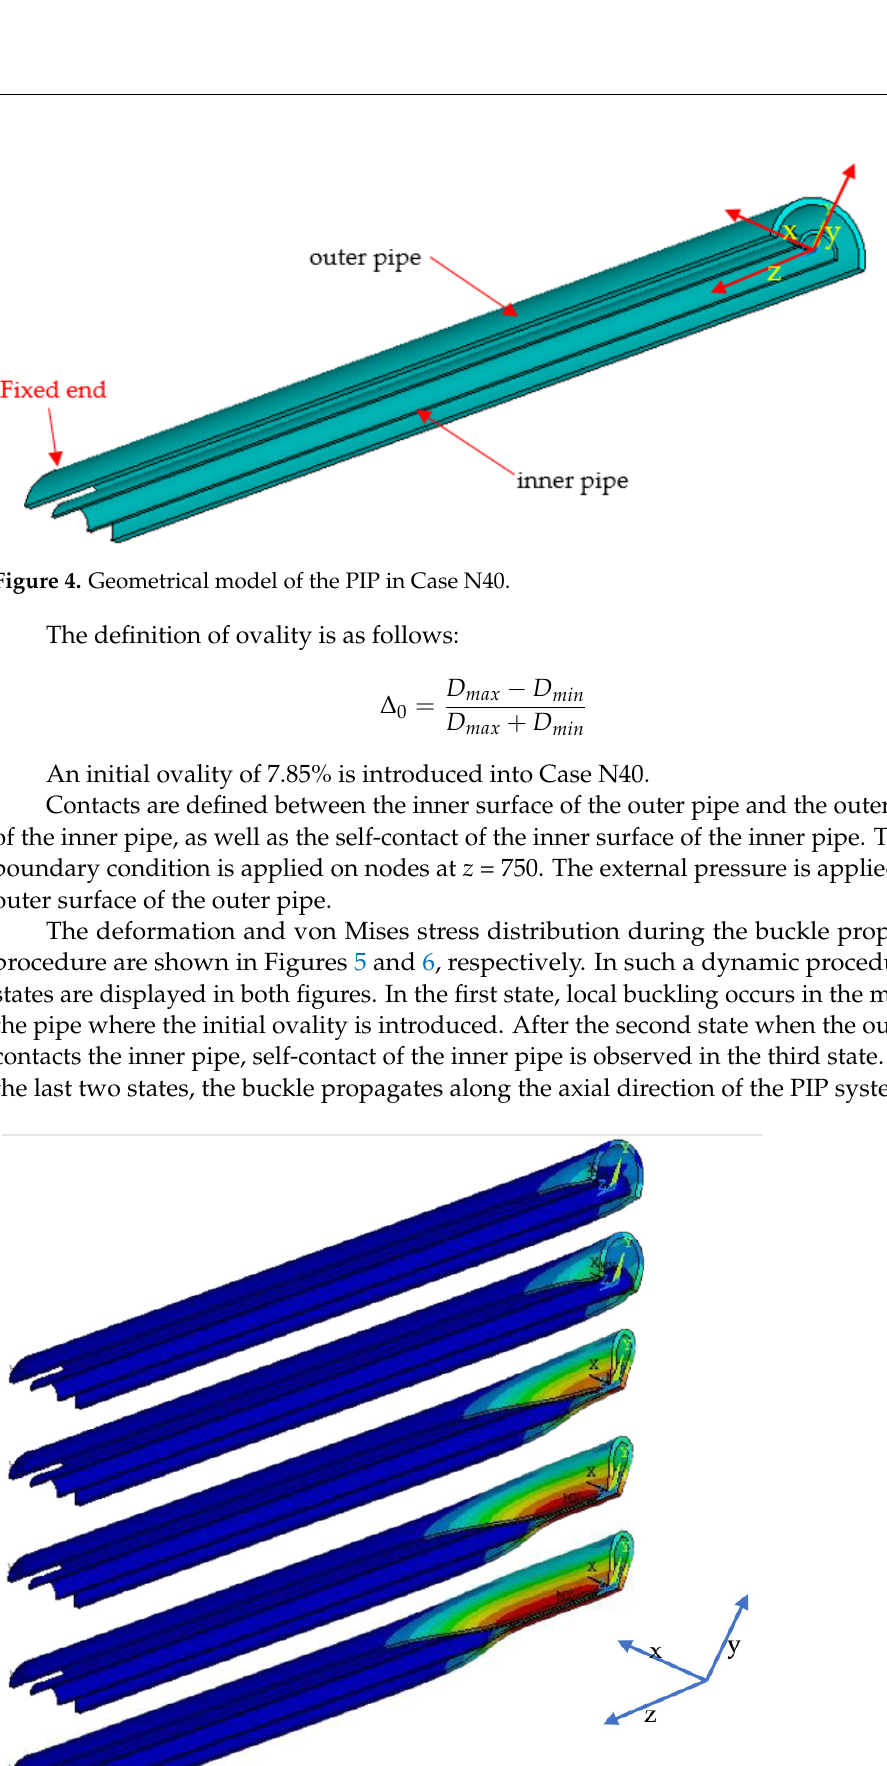
Figure 5. Deformation of PIP system during buckle propagation of Case N40 (unit: mm).